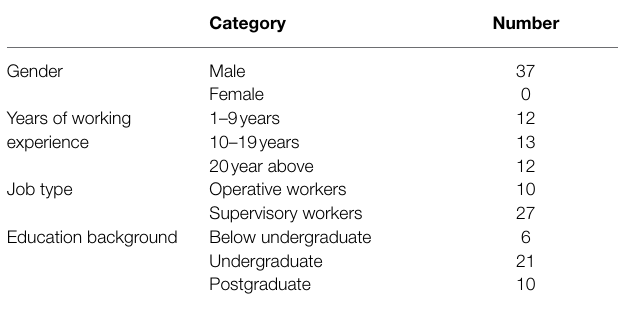
TABLE 1 | Basic information of the